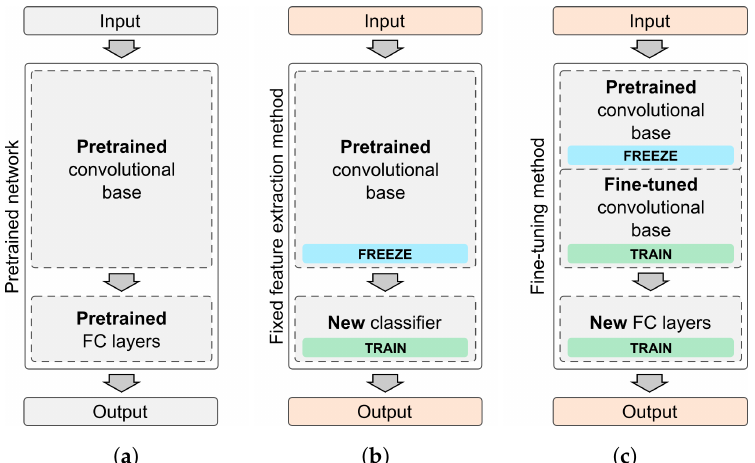
Figure 9. There are three transfer learning scenarios: ( a ) train whole model, ( b ) apply a new classifier on top of a pre-trained convolutional base, ( c ) fine-tune the base, by re-training one or more convolution